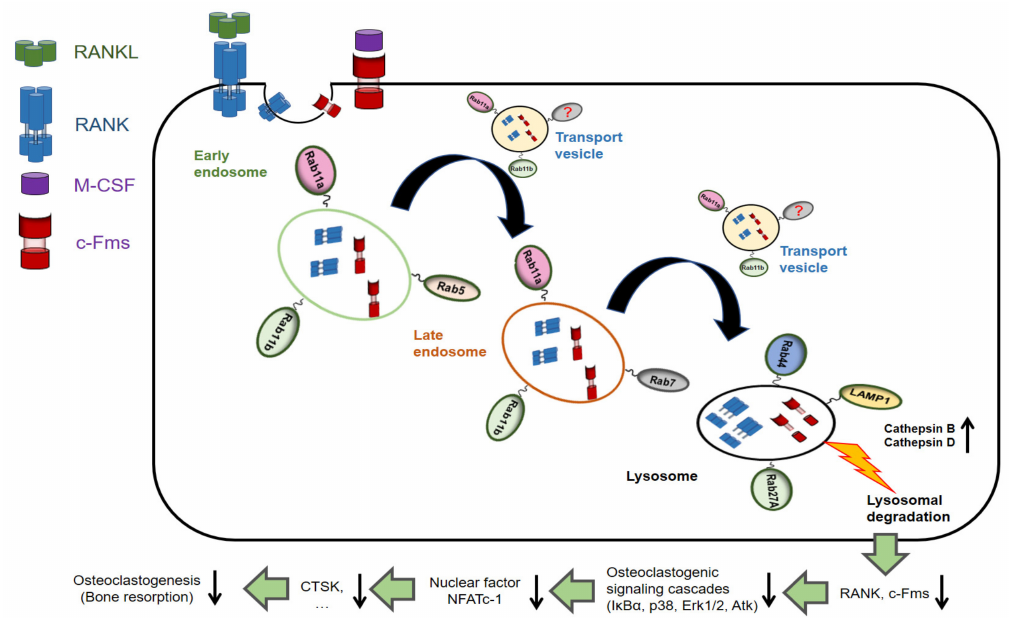
Figure 8. The model epitomizing the findings of our current works. c-Fms and RANK receptors were early internalized into early endosomes, and transported to late endosomes by the transport vesicles, which was subsequently fused with lysosomes for proteolysis of c-Fms and RANK surface receptors. Both homologs, Rab11a and b, upregulated at a late stage of osteoclast di ff erentiation dictated the transport of c-Fms and RANK surface receptors to the lysosome via the axis of early and late endosomes-lysosomes. Rab11-mediated lysosomal proteolysis of c-Fms and RANK receptors sequentially weakened the osteoclastogenic signaling cascades, inhibited the nuclear translocation of the transcription factor, NFATc-1, reduced the expression level of CTSK, and eventually abolished osteoclastogenesis (bone